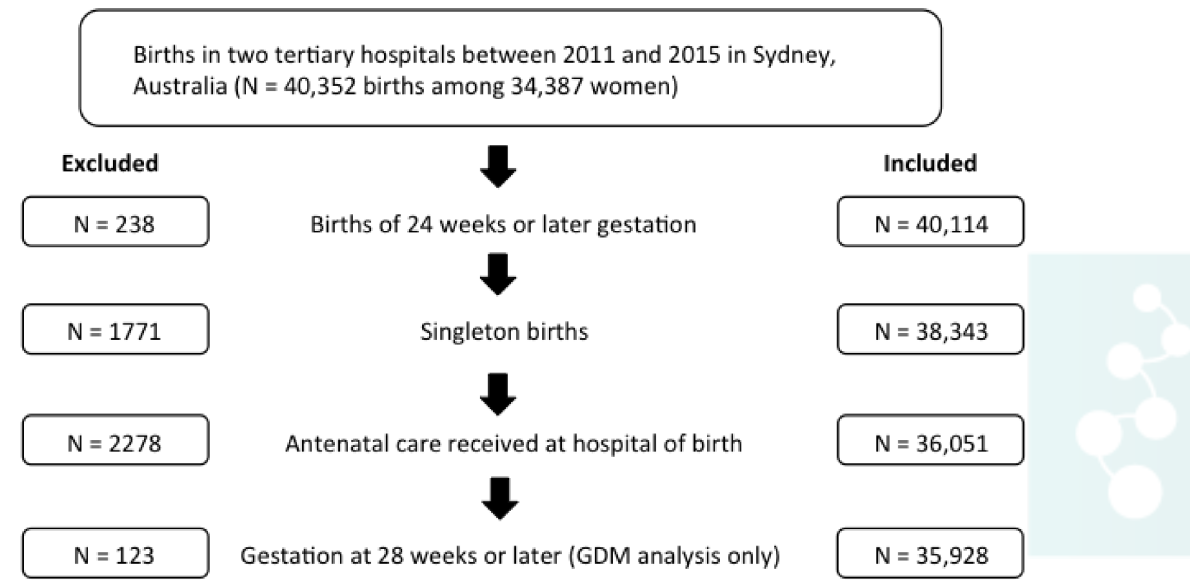
GDM = gestational